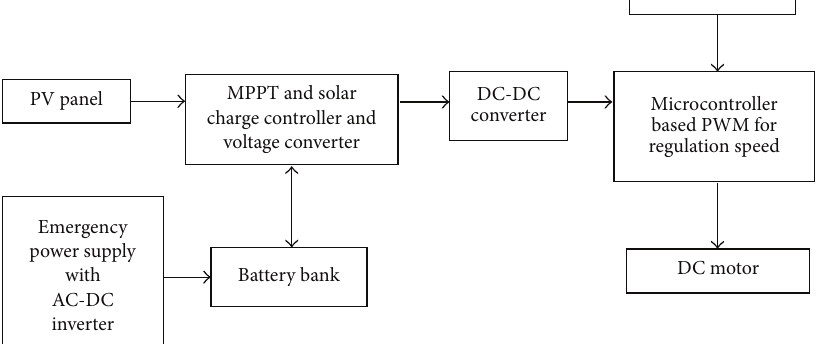
Figure 1: Microcontroller based